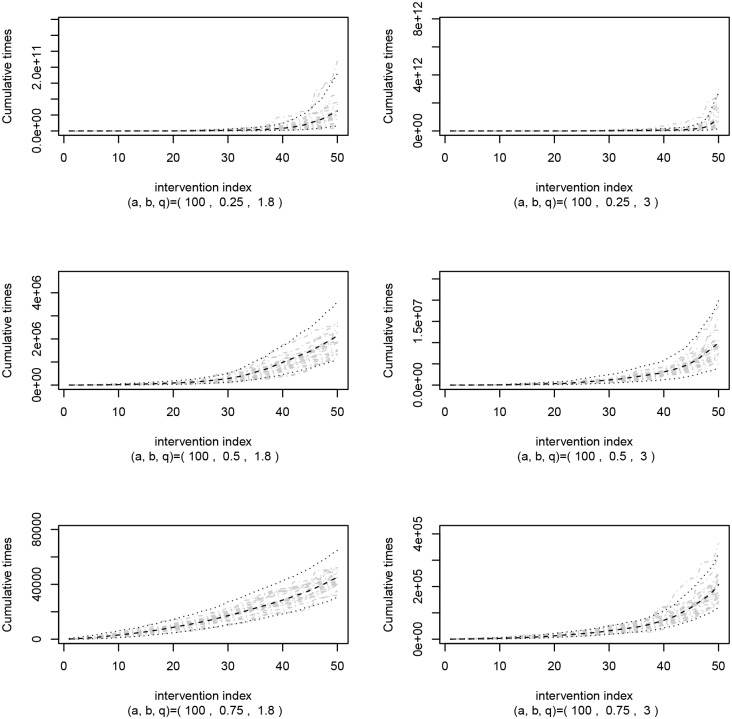
Explaining relationship.WGRP samples to explain relationship between values of β < 1 and q > 1.